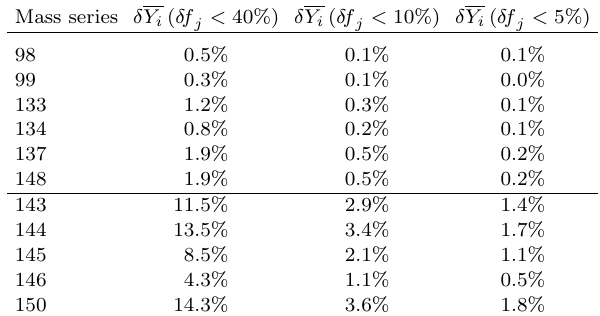
Table A.1. Accuracy of the irradiation-averaged fission yield for different deviations (40%, 10% and 5%) on the relative contributions to fissions of 239 Pu, 238 U and 241